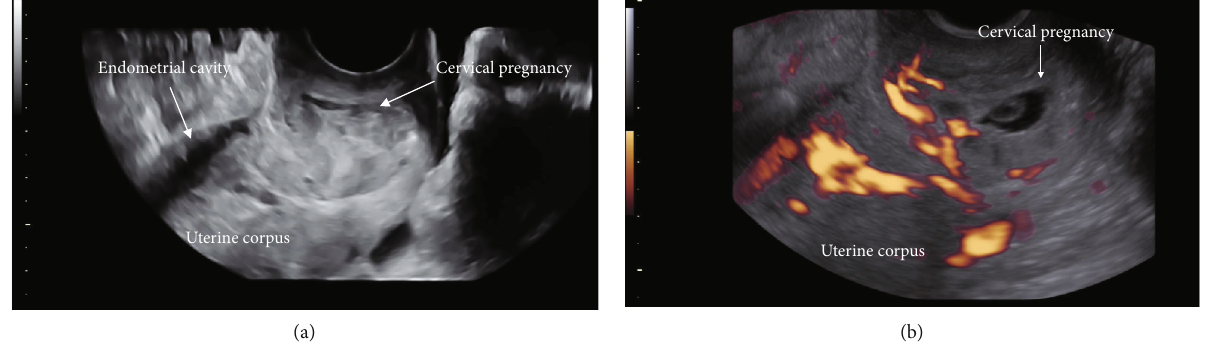
Figure 4: Cervical ectopic pregnancy in (a) 2D and (b) 3D transvaginal